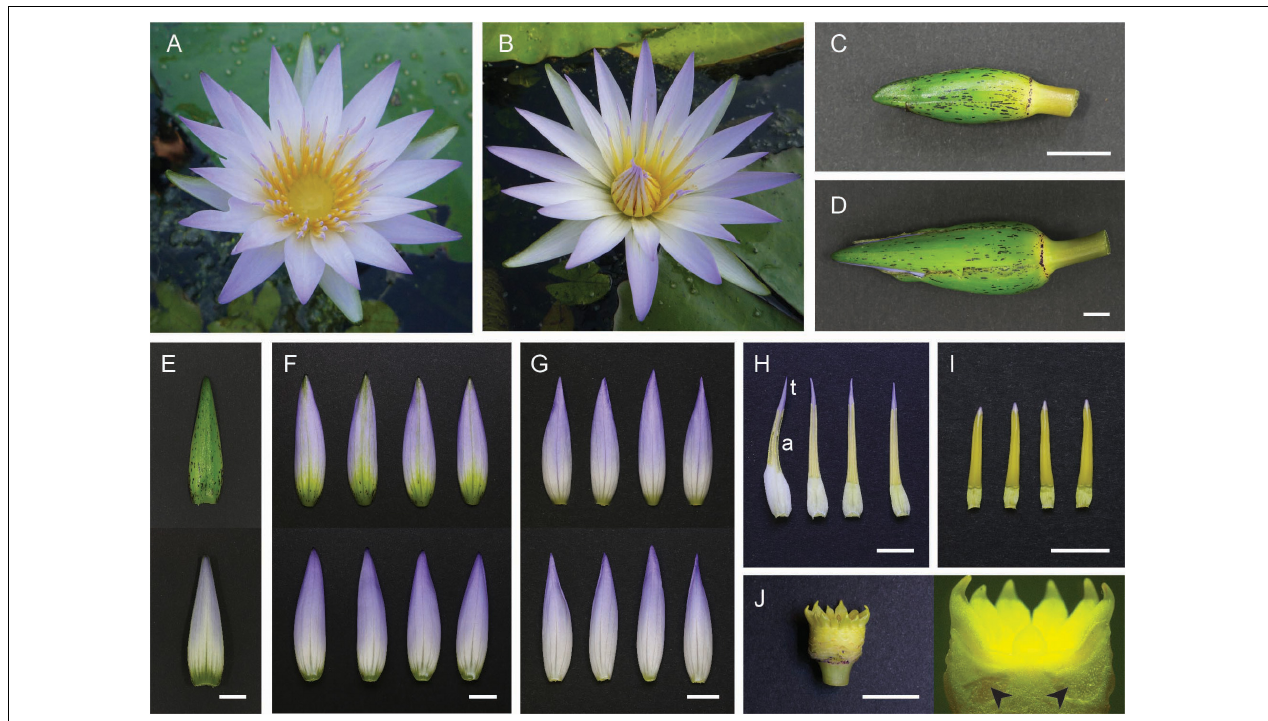
FIGURE 1 | Nymphaea caerulea floral components. (A) Flower at first day of anthesis; (B) flower at second day of anthesis. (C) A total of 2.5 cm long floral bud; (D) 5.5 cm long floral bud. (E) Green abaxial surface (top) and whitish adaxial surface (bottom) of a sepal. (F) Abaxial surface (top) and adaxial surface (bottom) of outer petals. (G) Abaxial surface (top) and adaxial surface (bottom) of inner petals. (H) Petaloid stamens, “t” indicates the cerulean tip and “a” indicates the anther portion. (I) Inner stamens. (J) Pluricarpellate pistil. Arrowheads indicate ovules within carpels. Scale bar, 1